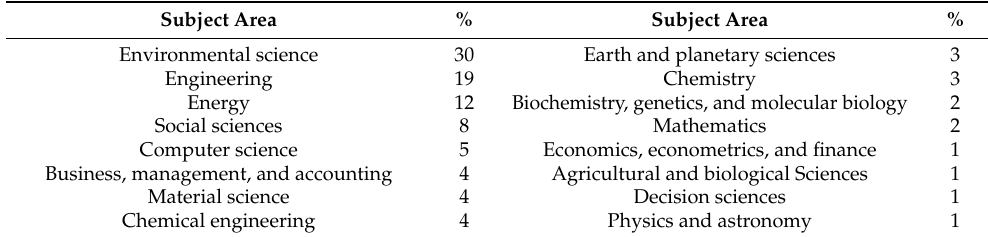
Table 3. Subject areas in the selected publications.